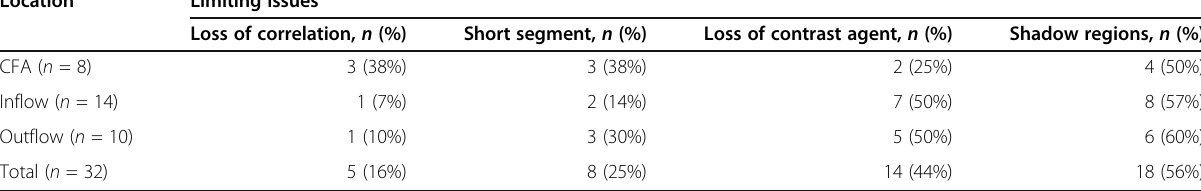
Table 4 Partial feasibility: limiting issue per location Location